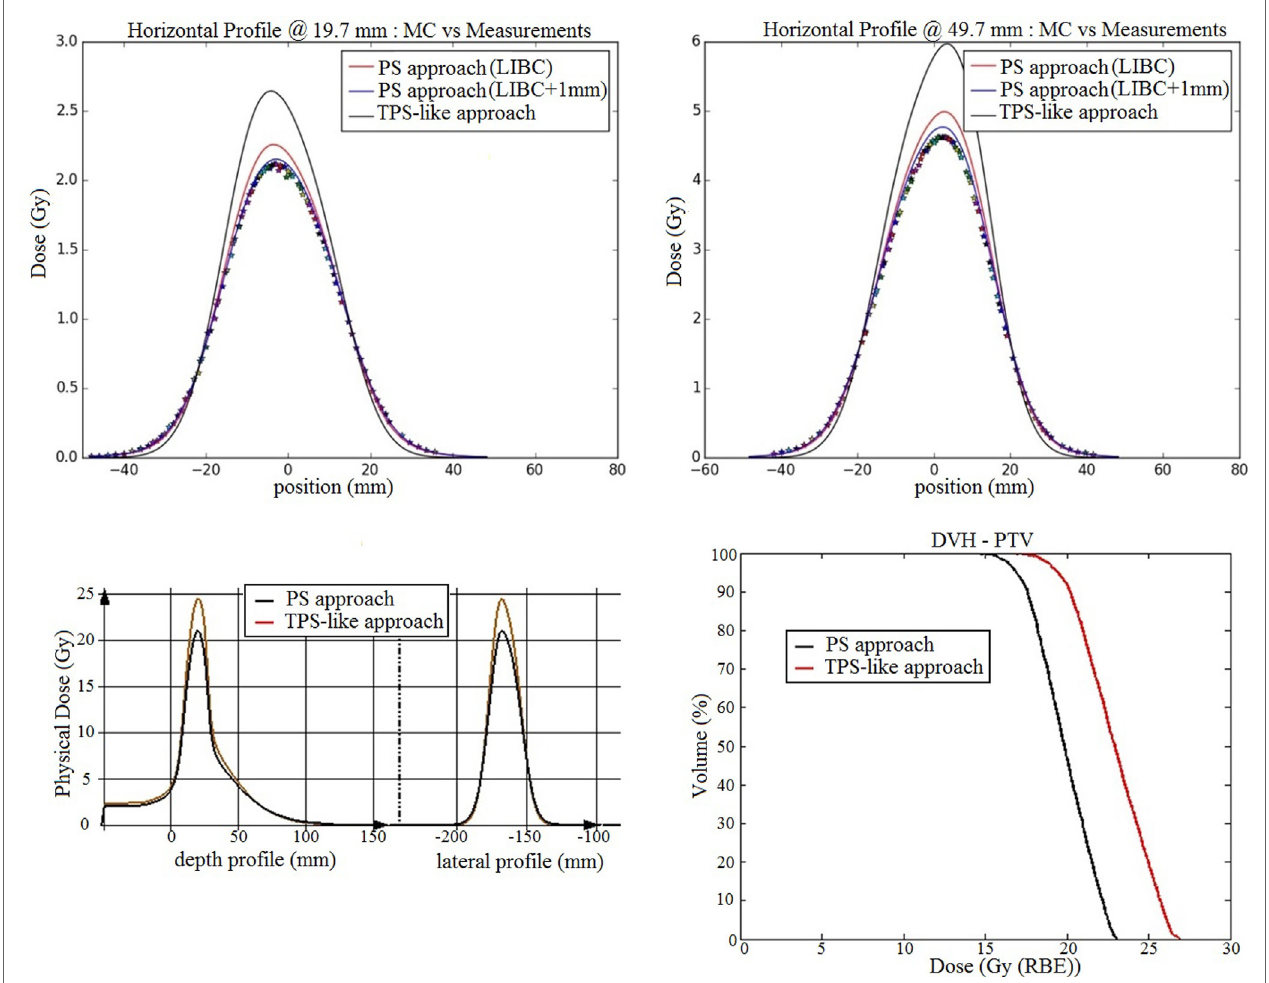
FigUre 9 | Ps approach against TPs-like approach for a small target clinical case: on the upper panels, dose verification measurements (stars) are displayed against simulations with the TPs-like approach using the database foci values (black), the normal Ps approach (red) with the foci in vacuum estimated from the database foci values, and the modified Ps approach (blue) using the foci values in vacuum calculated from the beam records, at two different depths in water (19.7 and 49.7 mm); on the bottom left panel, the dose profile at the PTV level in the cT patient geometry is plotted in red for the TPs-like approach and black for the Ps approach, using the reference liBc foci, for one beam; the bottom right panel displays dose volume histograms of the dose calculated with the two studied